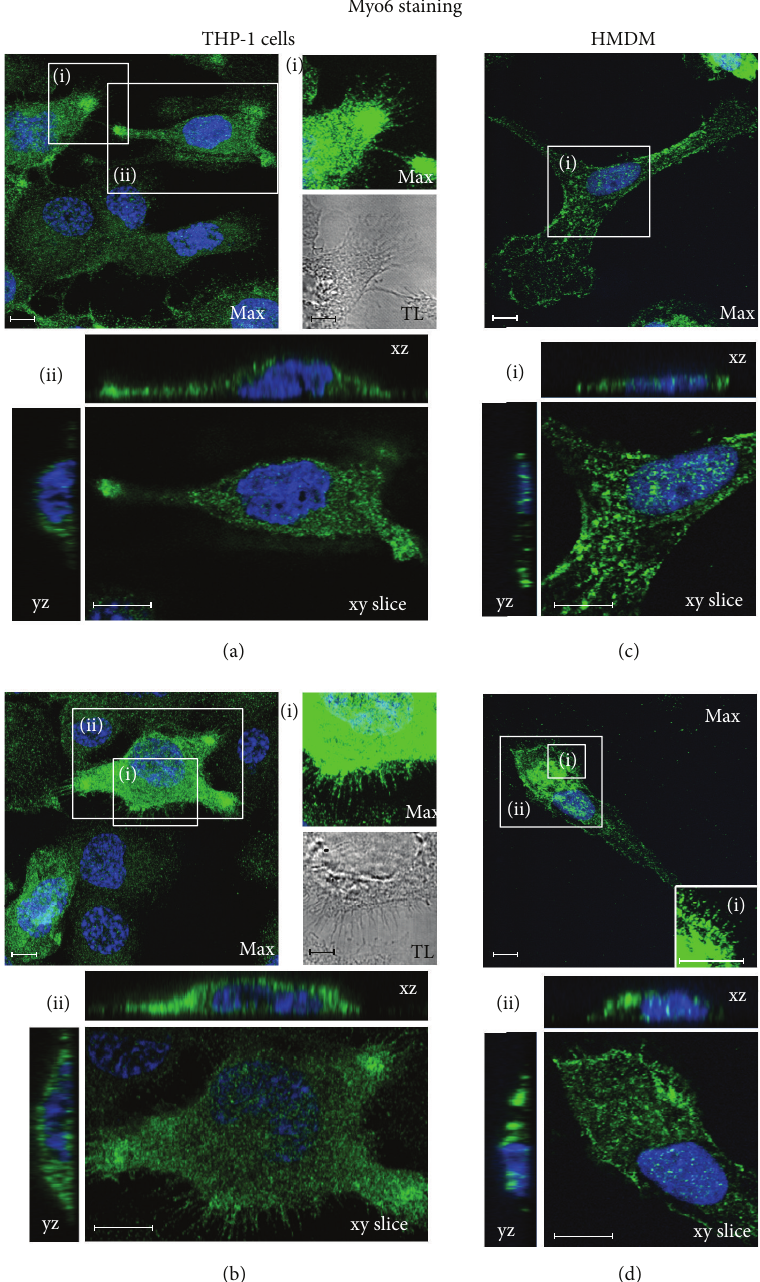
Figure 5: THP-1 macrophages (a, b) or HMDM (c, d) were fixed and probed with IgG polyclonal rabbit anti-Myo6 followed by anti-rabbit antibody conjugated to Alexa488 (green) and counterstained with DAPI (blue) to highlight cell nuclei. Z-stacked images were taken using a Leica SP5 CLS microscope. (a)-(b) THP-1 cells, labeled as described previously, are shown in maximum projections through the stacks, provided for orientation. Enlargements (i) of the regions indicated show cellular projections labeled for Myo-6. These projections are also visible in the transmitted light images (TL). Selected cells (ii) are enlarged below the maximum projections and shown as confocal xy slices withverticalxzandyzsectionsthroughthemiddleofthecells.(c)-(d)HMDMcellslabeledasdescribedpreviouslyareillustratedinmaximum projections through the stacks. Selected regions (c (i), d (ii)) are enlarged and shown as confocal xy slices with vertical xz and yz sections through the middle of the cells. One region (d (i)) is enlarged as an inset to illustrate staining in short cellular projections. Typical images taken from a minimum of three separate experiments with THP-1 cells, or HMDM from three individual donors, are shown. Scale bars = 10 𝜇